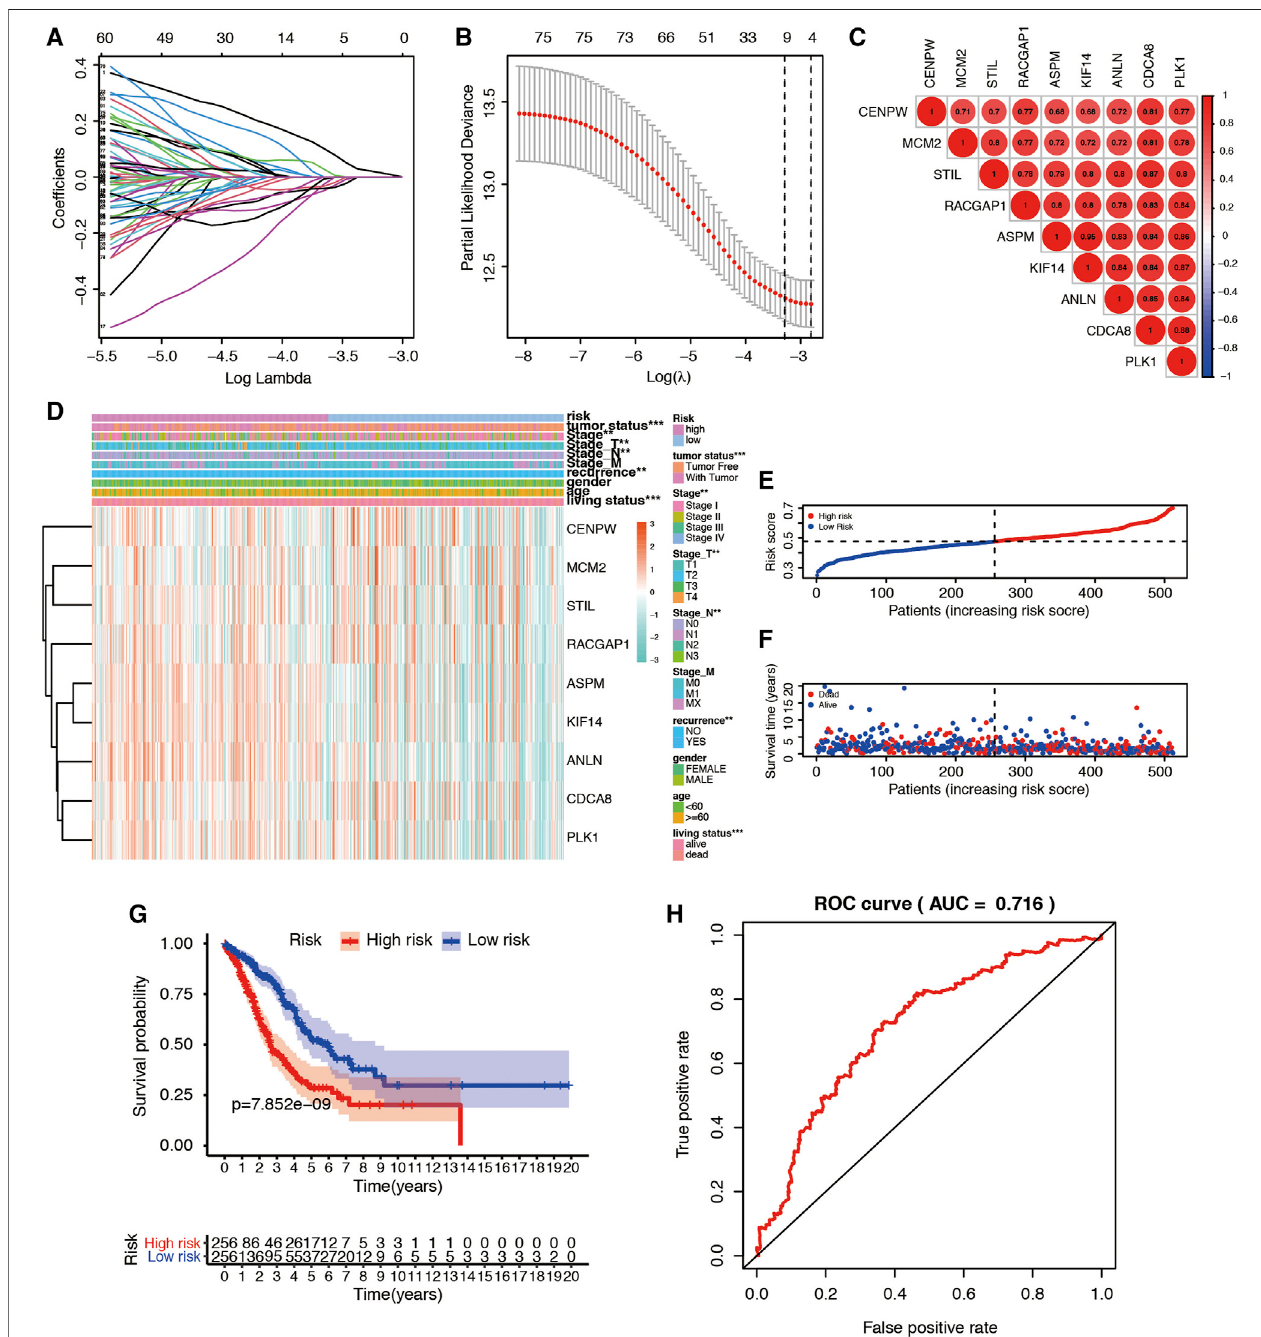
FIGURE 6 | Construction and validation of mRNAsi-related signature for LUAD patients. (A) Lasso regression identi fi ed the prognostic model in LUAD. (B) Cross- validationtoselecttheoptimaltuningparameter( λ ).Thereddottedverticallinecrossesovertheoptimallog λ . (C) Therelationshipamongninekeygenes.Thebiggerthe circle size, the more correlative two genes are. (D) The heatmap shows the expression of the 9 genes in high-risk and low-risk LUAD patients. The distribution of clinicopathological characteristics was compared between the high-risk and low-risk groups. * p < 0.05, ** p < 0.01 and *** p < 0.001. (E) Risk score distribution of patients in the prognostic model. (F) Survival status scatter plots for patients in the prognostic model. (G) Kaplan-Meier curve analysis of the high-risk and low-risk groups. (H) Time-dependent ROC curve analysis of the prognostic model.